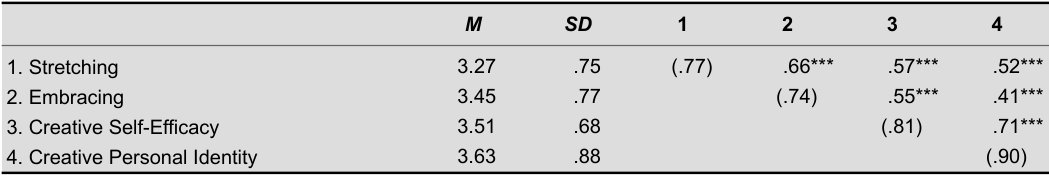
Descriptive Statistics and Correlations of Variables Used in the